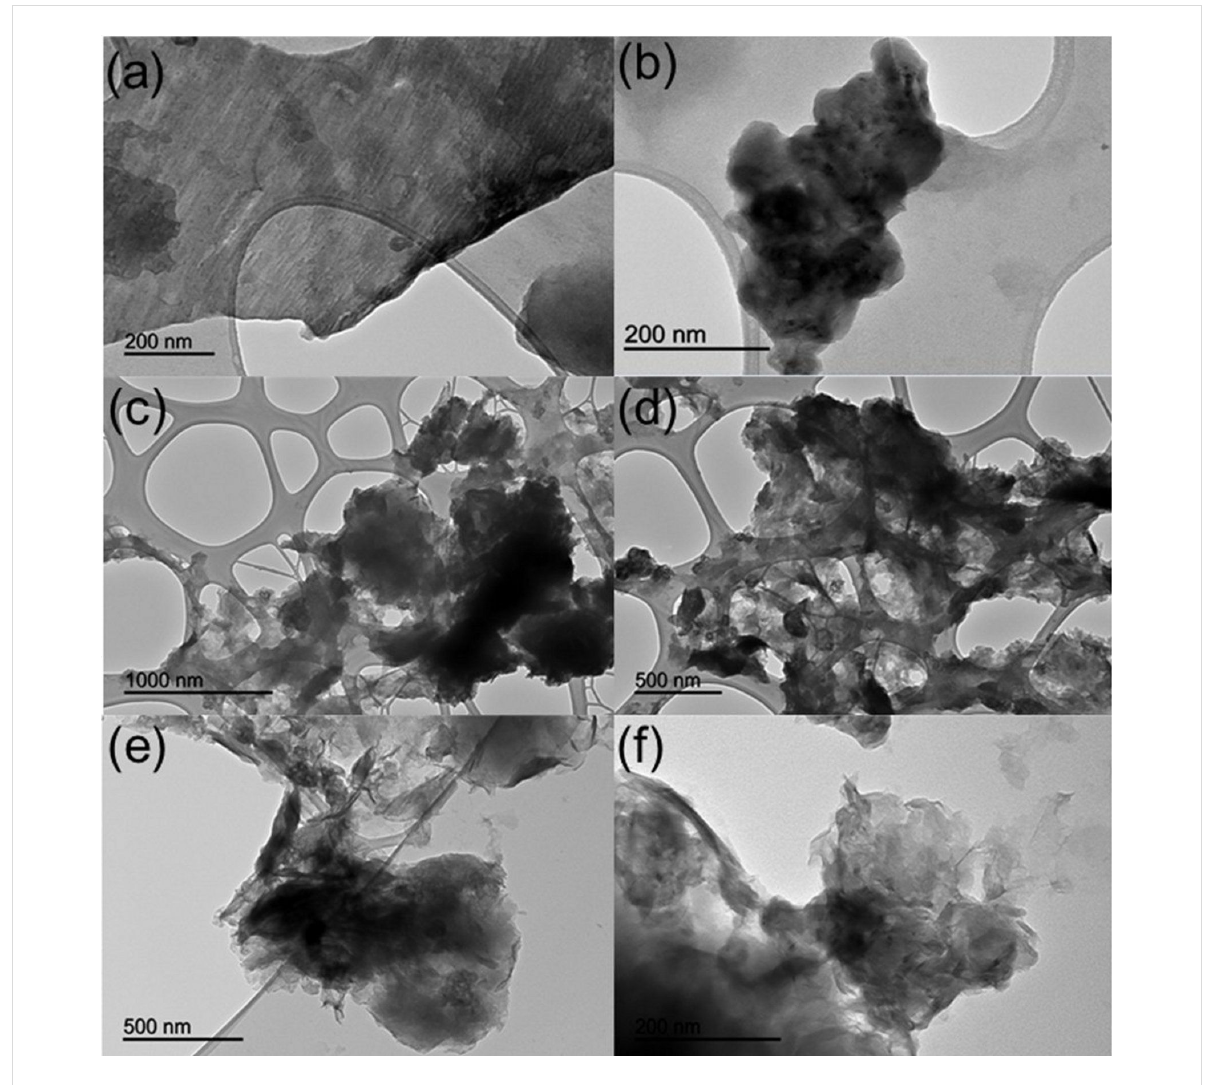
Figure 3: TEM micrographs at different magnifications of (a and b) RGO, (c and d) 1% Fe/RGO, and (e and f) 1% Co/RGO.